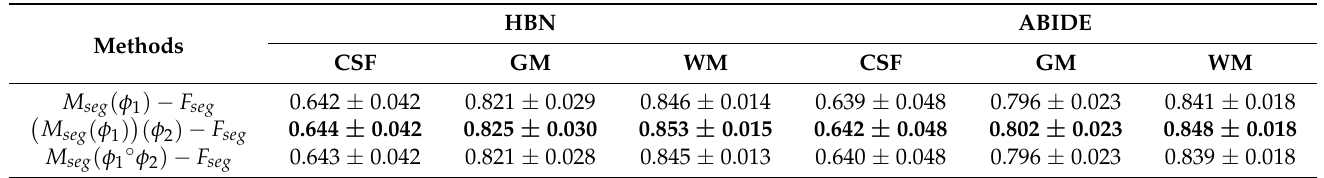
Table 7. Test results of output images from registration and augmented network for two datasets. Bold numbers indicate the best